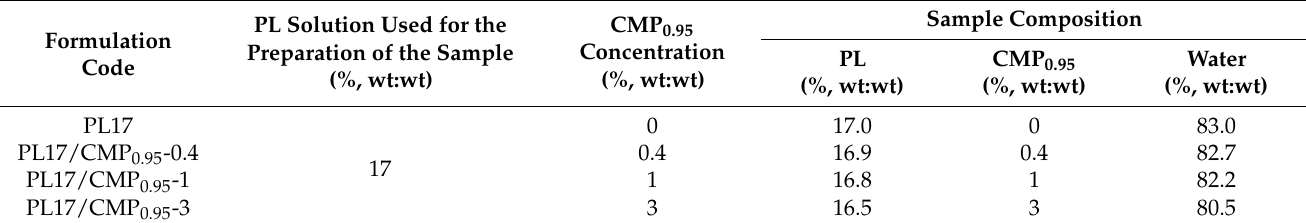
Table 1. Composition of some of the studied formulations.